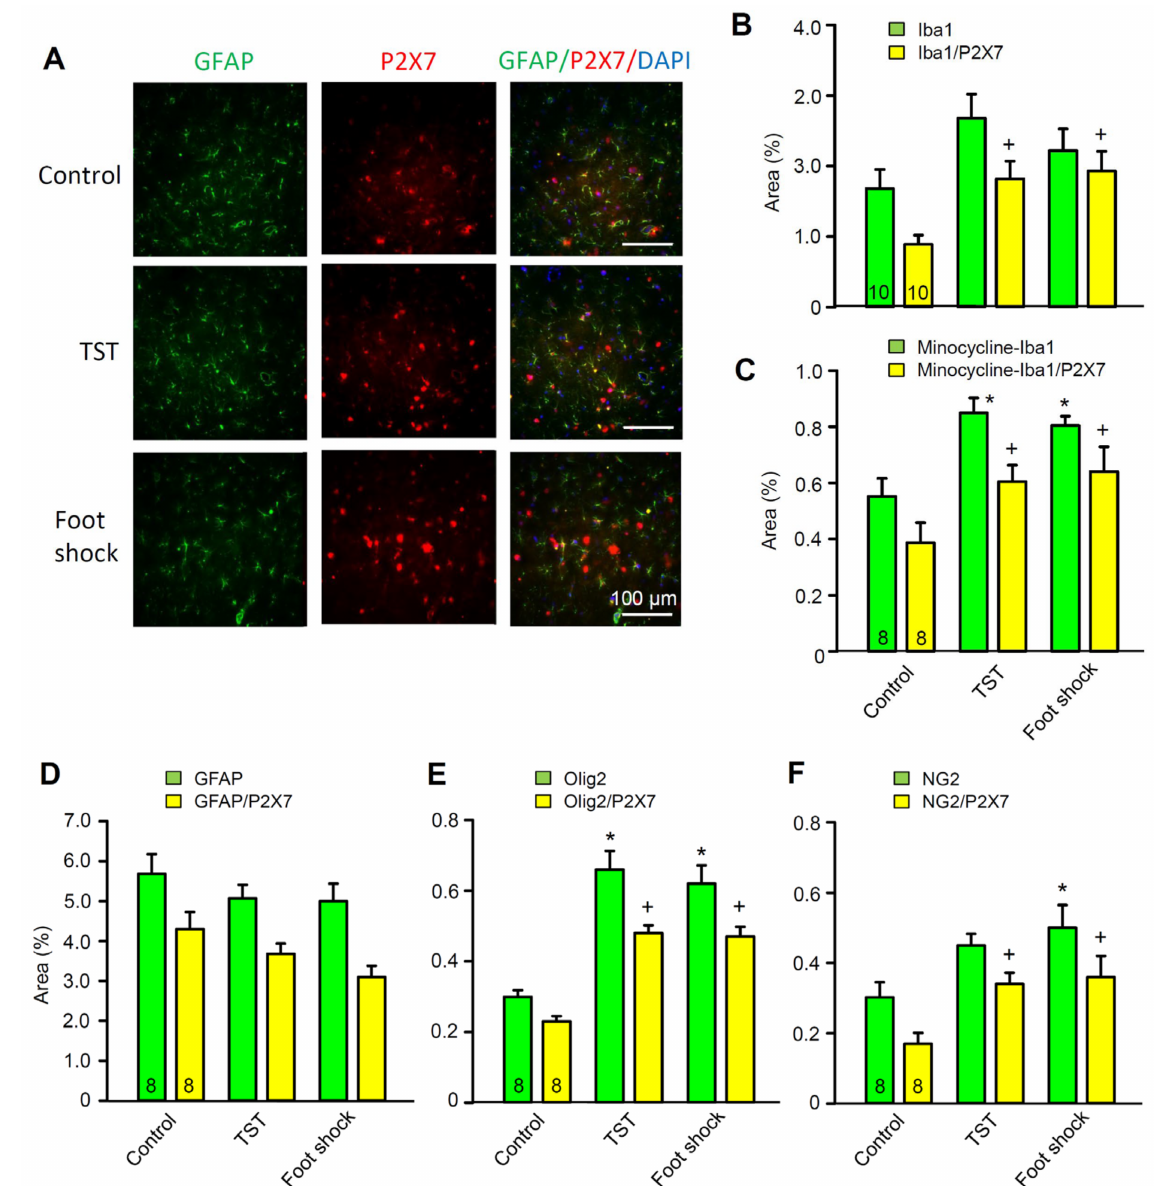
Figure 6. Effects of the TST and foot shock on P2X7R-immunoreactivities (IRs), with microglial (Iba1), astroglial (GFAP), and (pro)oligodendroglial (Olig2, NG2) markers as well as their co-localization with 4’,6-diamidino-2-phenylindol (DAPI) in the hippocampal CA1 region of 3-week old rats. ( A ) fluorescence microscopic pictures of immunopositive cells and DAPI-labelled nuclei. The as- trocytic marker glial fibrillary acidic protein (GFAP; green fluorescence)-IR co-stains with the red fluorescent P2X7R-IR, and the blue fluorescent DAPI. Triple-labelling of all three IRs is displayed in the right row of the picture as shown. One representative snapshot obtained from the hippocampi of 8 animals. Scale bars, 100 µ m. ( B – F ) The stained sections were examined under 400 × magnification of the microscope over the whole image; the IF was evaluated with ImageJ software and, after subtracting the background, it was expressed as a % of the whole area. ( B , C ) the Iba1/P2X7-IR was increased by the TST and foot shock both with and without minocycline pretreatment of mice (see Section 4). However, minocycline largely decreased the number and density of the microglial cells. ( E , F ) oligodendrocytes and NG2 glial cells responded to the TST and foot shock in a similar manner as microglia did. ( D ) neither the GFAP- nor the GFAP/P2X7R-IR changed after TST or foot shock stimulation in comparison with the unstressed controls. * p < 0.05; statistically significant